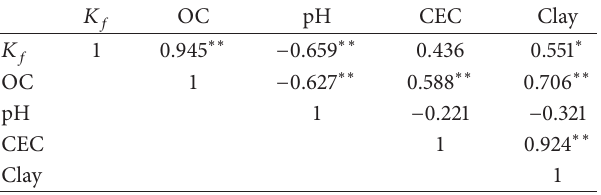
Table 4: Pearsons correlation coefficients ( 𝑟 ) between certain soil properties and dinoseb adsorption capacity